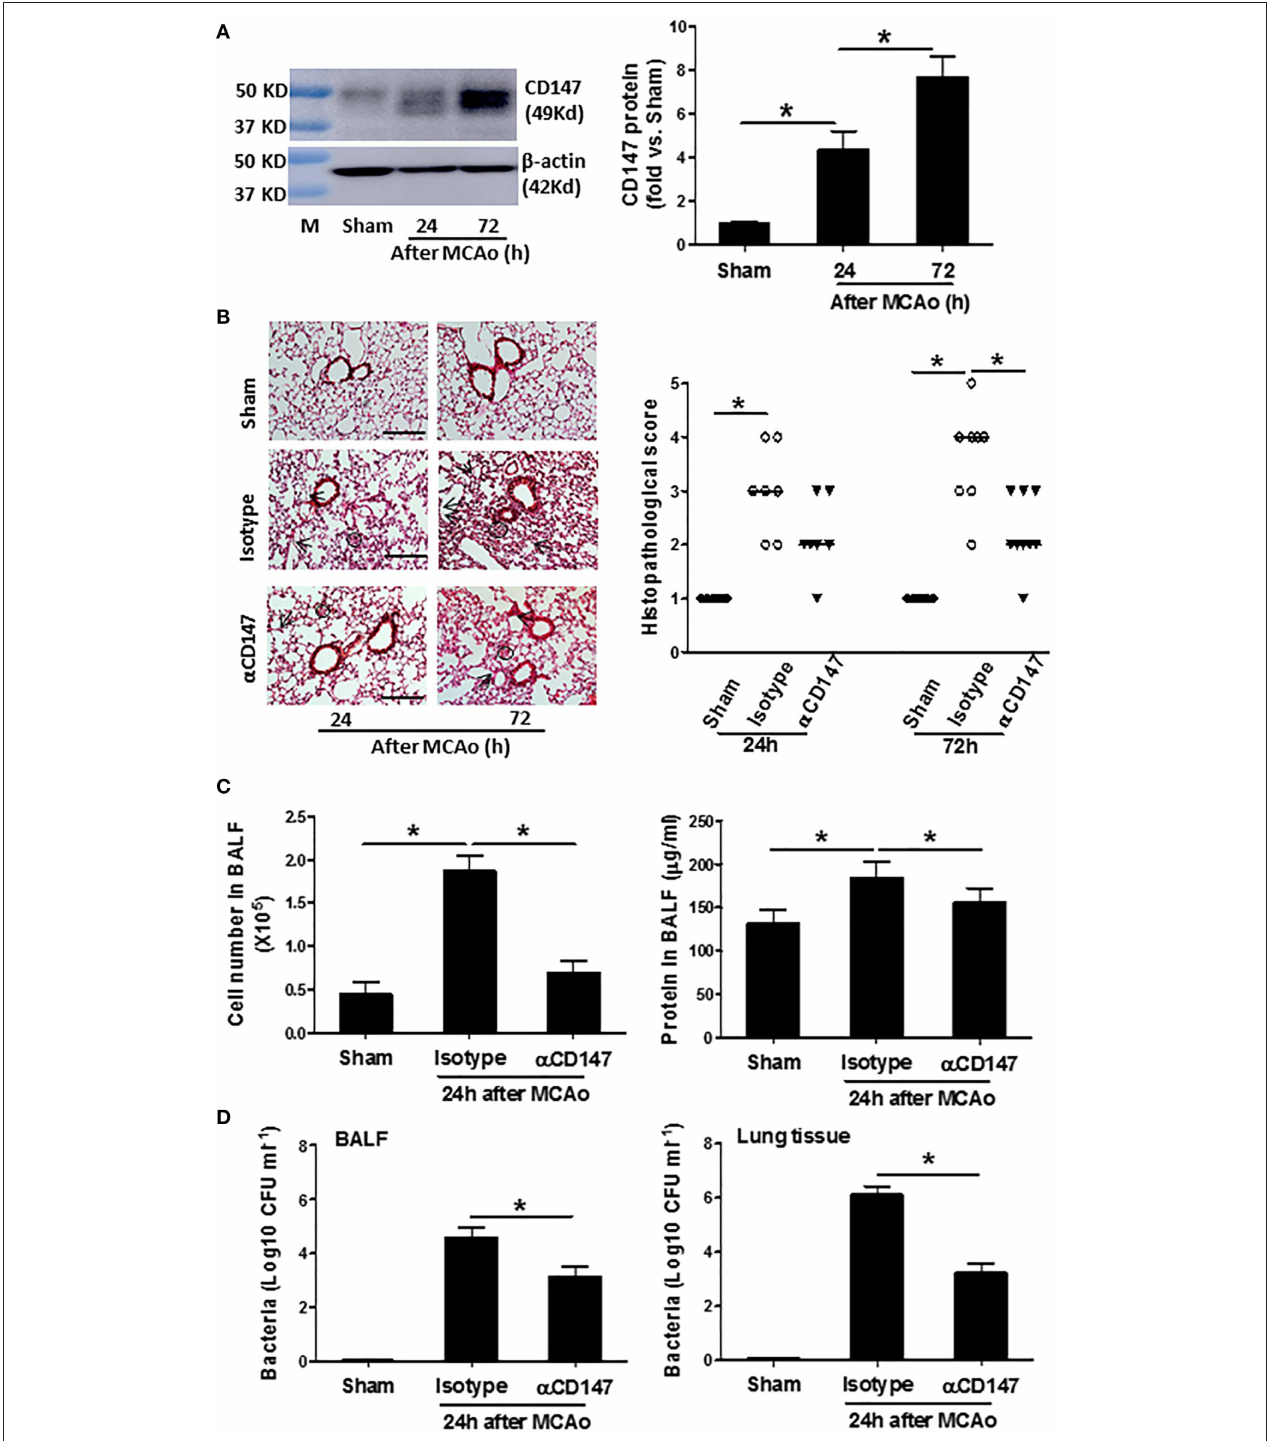
FIGURE 1 | Inhibition of CD147 attenuates post-stroke pneumonia. (A) Representative images of western blots showing CD147 protein levels in the lung tissues and semi-quantitative analysis of immunoblots. M indicates protein marker. n = 4 per group. (B) Left panel: representative images of hematoxylin and eosin-stained lung sections. Black circles indicate the patchy areas of cellular consolidation. Arrows indicate the intra-alveolar infiltrates. Bar = 200 µ m. Right panel: quantitative analysis of histopathological lung injury scores. Bars are median values. n = 6–9 per group. (C) The number of cells (left panel) and levels of protein concentration (right panel) in BALF at 24h after stroke. n = 6 per group. (D) Quantitative analysis of bacterial loads by measuring colony-forming units (CFU) in BLAF (left panel) and lung tissue homogenate (right panel) cultures in indicated groups at 24h after stroke. n = 6 per group. * P < 0.05.